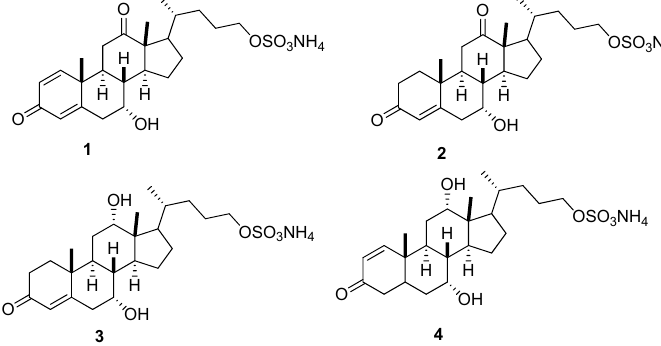
Figure 1. Structures of sulfated BAs analyzed in this study. Compound 1 , 12-keto-1,4-diene 3kPZS; compound 2 , 12-keto-4-ene 3kPZS; compound 3 , 4-ene 3kPZS, and compound 4 , 1-ene 3kPZS.